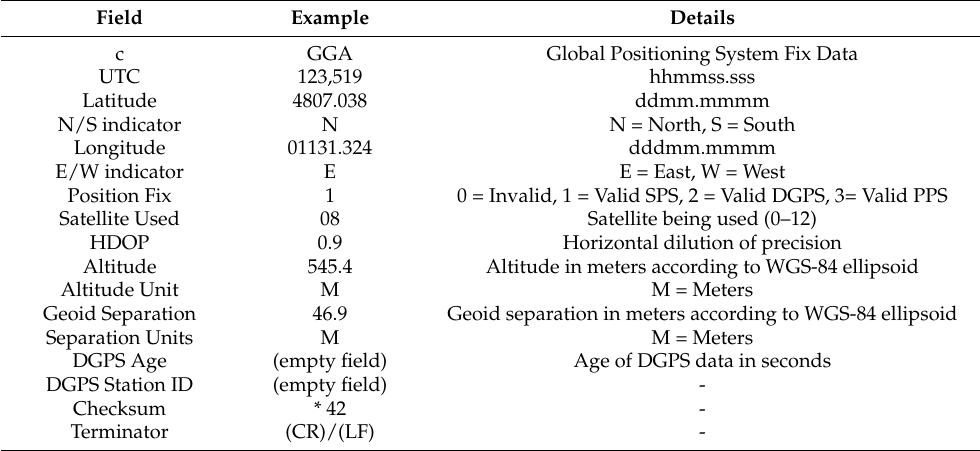
Table 1. GGA data details and format.